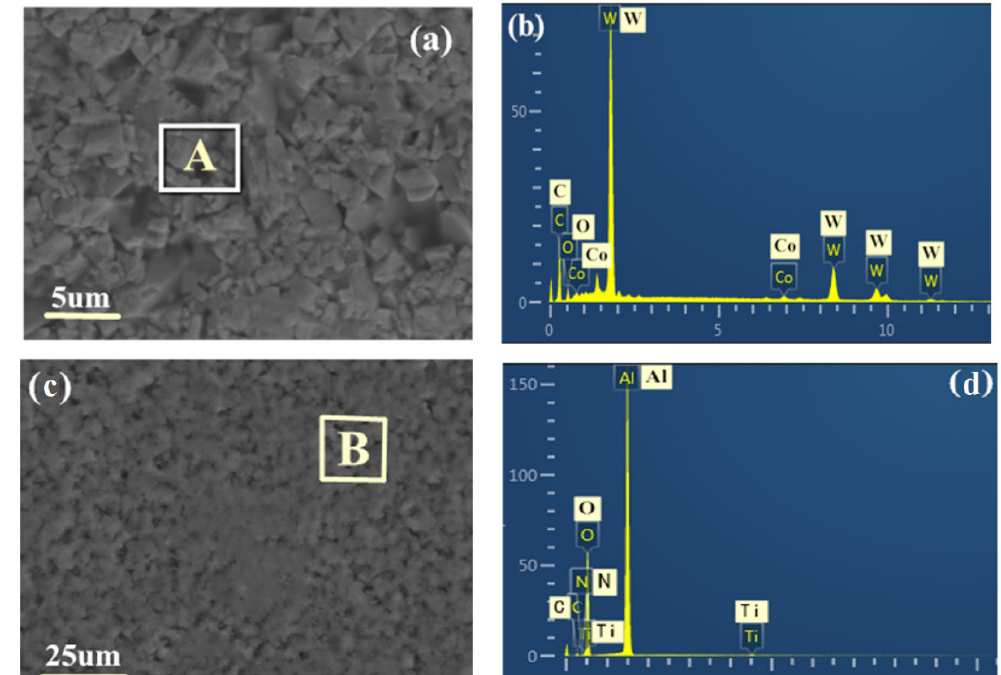
Figure 2. SEM and EDS analysis of the WC/Co matrix and TiAlN coating (( a , b ) are the SEM and EDS of the WC/Co matrix; ( c , d ) are the SEM and EDS of TiAlN coating).